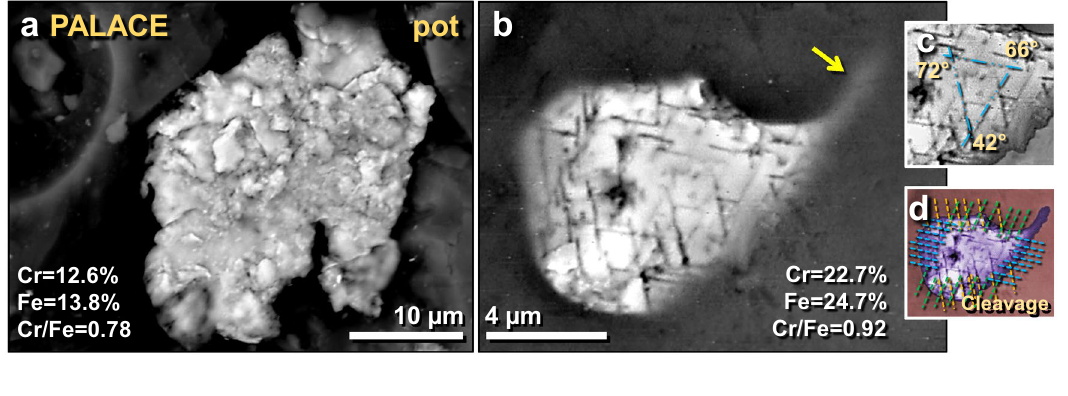
Figure 33. SEM images of melted chromite grains found on a melted potsherd from the palace. ( a ) Shattered, polycrystalline chromite grain that appears to have become agglutinated while molten. ( b ) Melted chromite grain, displaying cleavage (lamellae) suggestive of thermal and/or mechanical shock metamorphism at ~ 12 GPa; ( c ) close-up image showing angles between three sets of crystalline cleavage; ( d ) manually constructed EDS- based phase map showing chromite (purple) embedded in Ca–Al–Si matrix. The lines mark three sets of cleavage extending across the entire grain. A melt tail merging with the matrix is observed to trail off to the upper right of the grain at arrow.